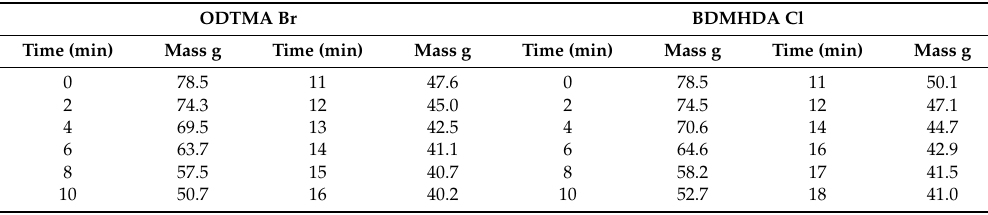
Table 2. Drying in MW oven: Granules included ODTMABr or BDMHDACl a .